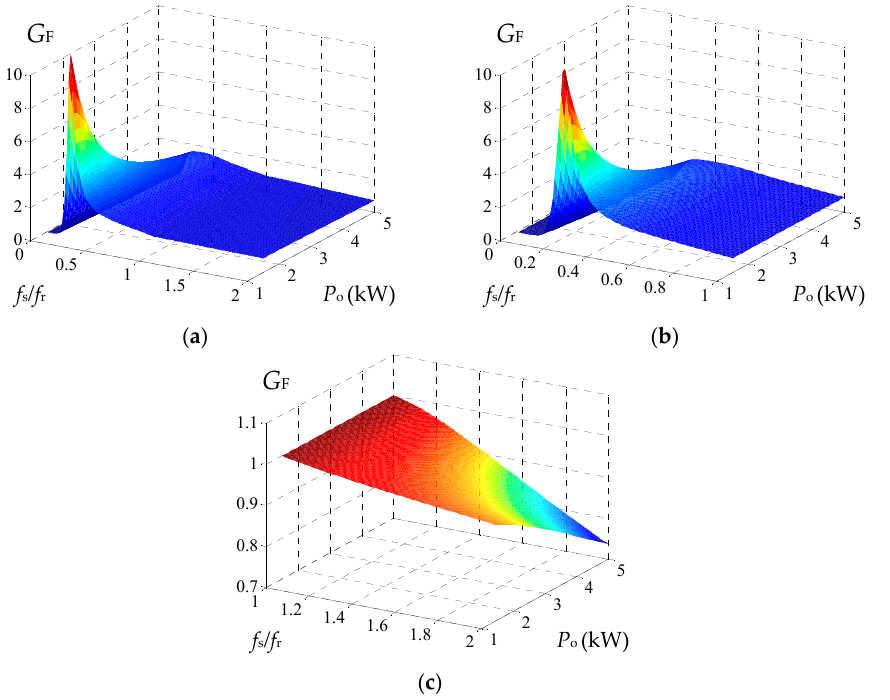
Figure 5. Voltage gain obtained by FHA model in forward mode: ( a ) whole frequency range; ( b ) f s < f r ; ( c ) f s ≥ f r .